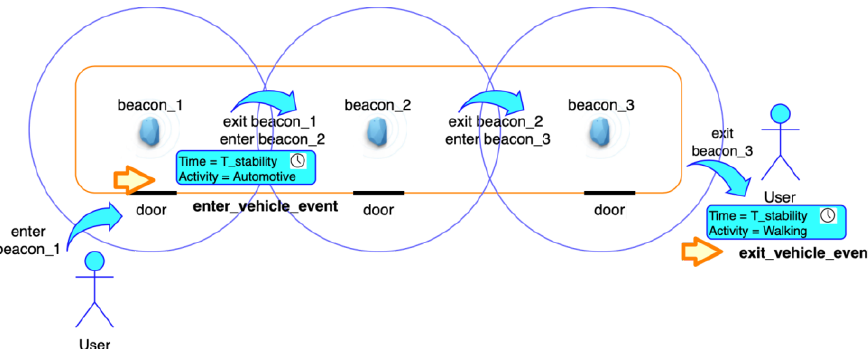
Figure 5. Diagram showing the interactions with a bus equipped with three beacons.